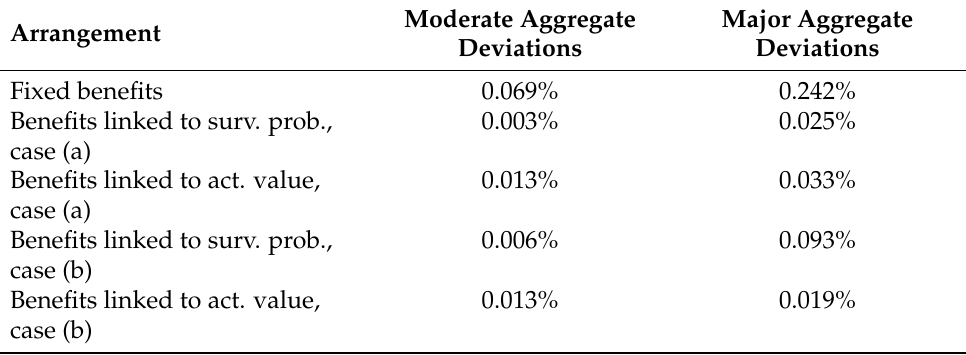
Table 1. Periodic fee ξ (to be charged each year to the policy fund